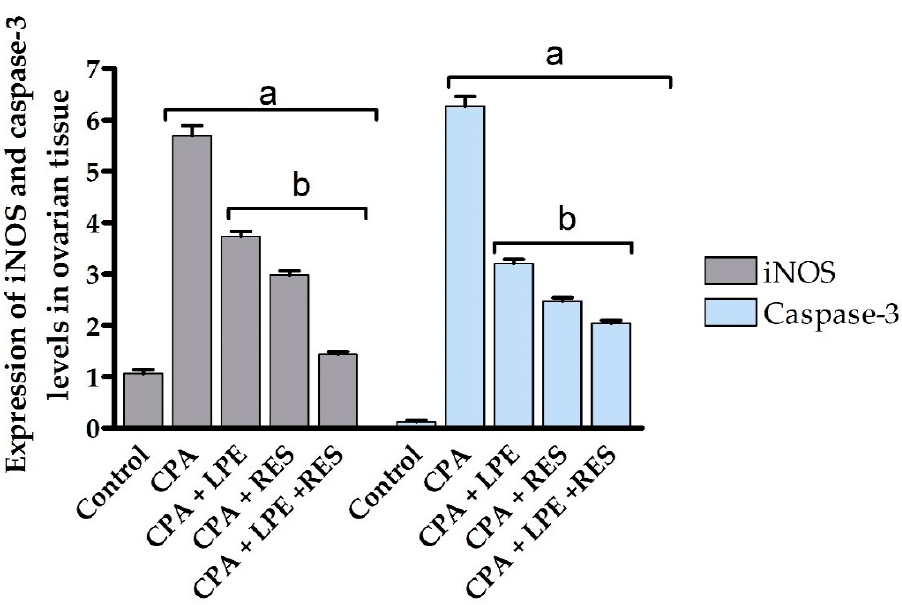
Figure 6. Effects of LPE and/or RES on the expression of iNOS and Casp3 levels in ovarian tissue of cyclophosphamide-treated rats. Data expressed as mean ± SEM. a p < 0.05 versus control group; b p < 0.05 versus a CPA group, (n = 7). CPA: Cyclophosphamide, LPE: Lemon peel extract, RES: resvera- trol.